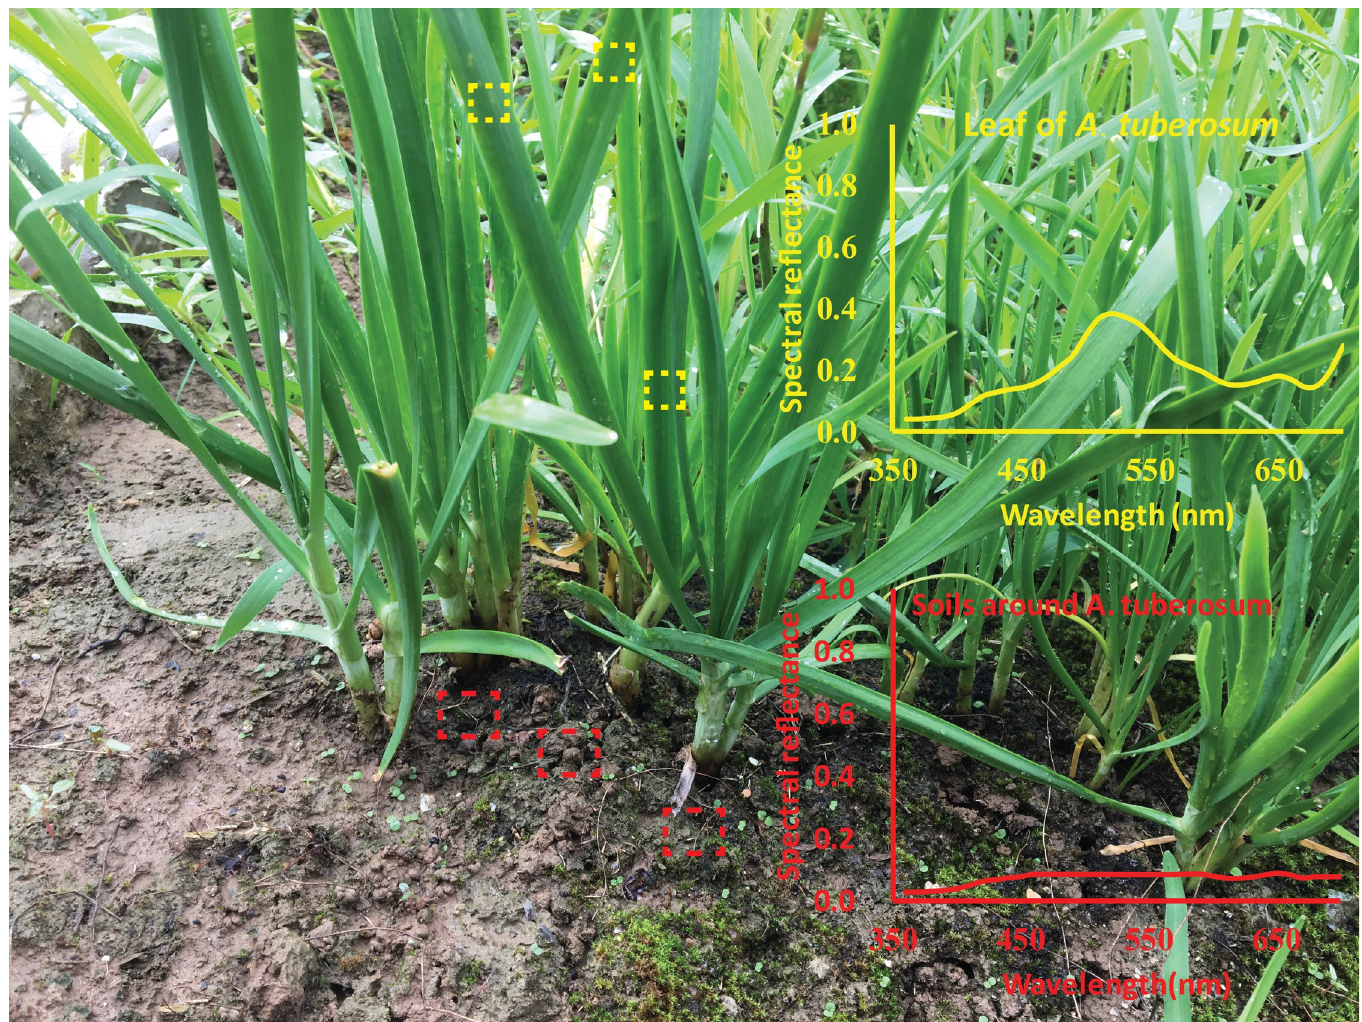
Fig 7. Reflectance spectra of living environment in chive gnat Bradysia odoriphaga . Dashed boxes with yellow colour represent the measure sites of leaves of A . tuberosum . Dashed boxes with red colour represent the measure sites of soils around A . tuberosum .